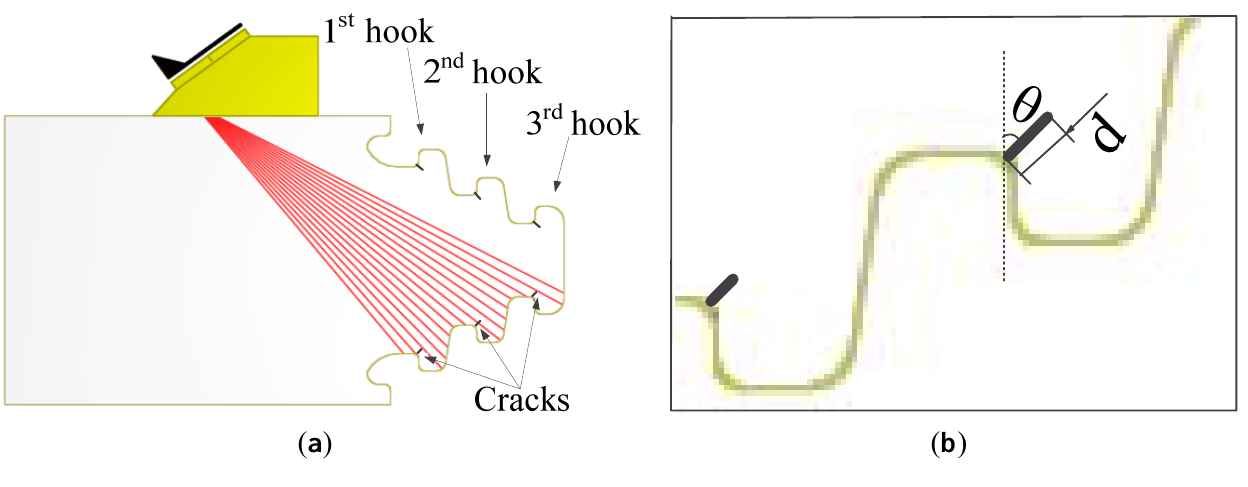
Table 1. Orientation and depth of crack in the